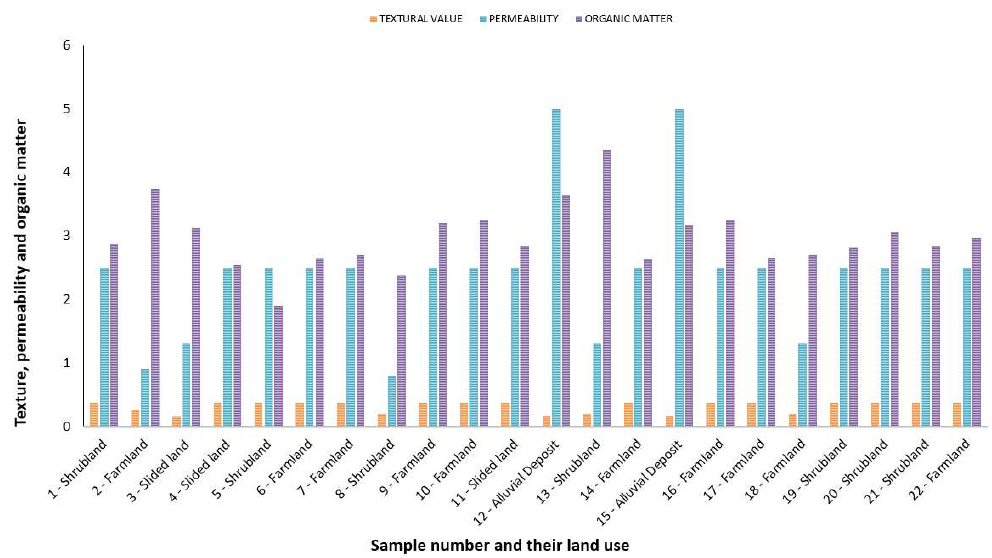
Figure 7. The distribution of soil characteristics within different land cover types in Koromi catchment of Jos East LGA.